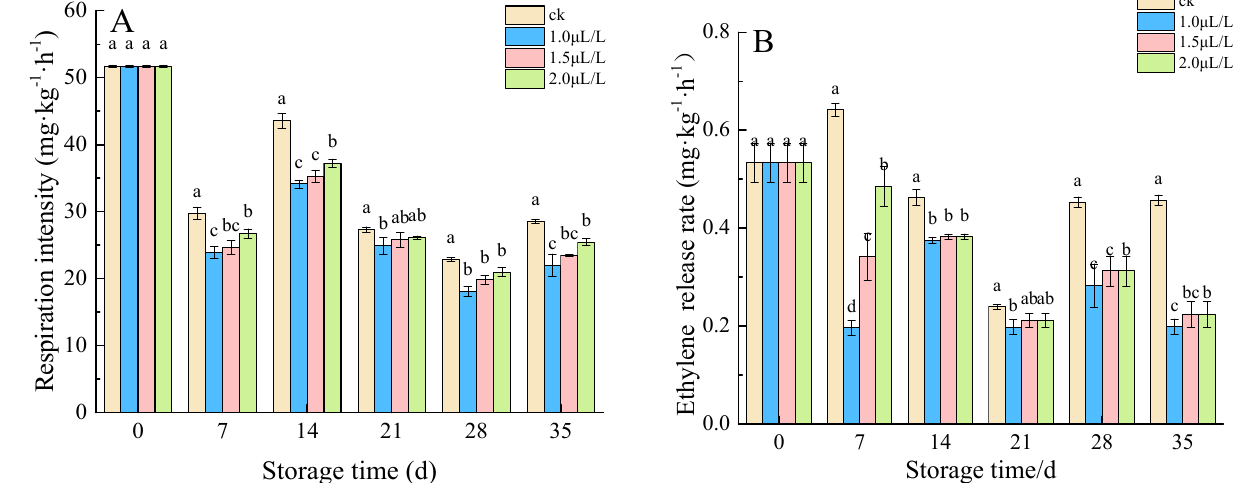
Figure 2. Effects of 1-MCP on respiratory intensity ( A ) and ethylene content ( B ) in root mustard. Different letters at each time point indicated a significant difference between treatments ( p < 0.05) by Duncan’s multiple range test.